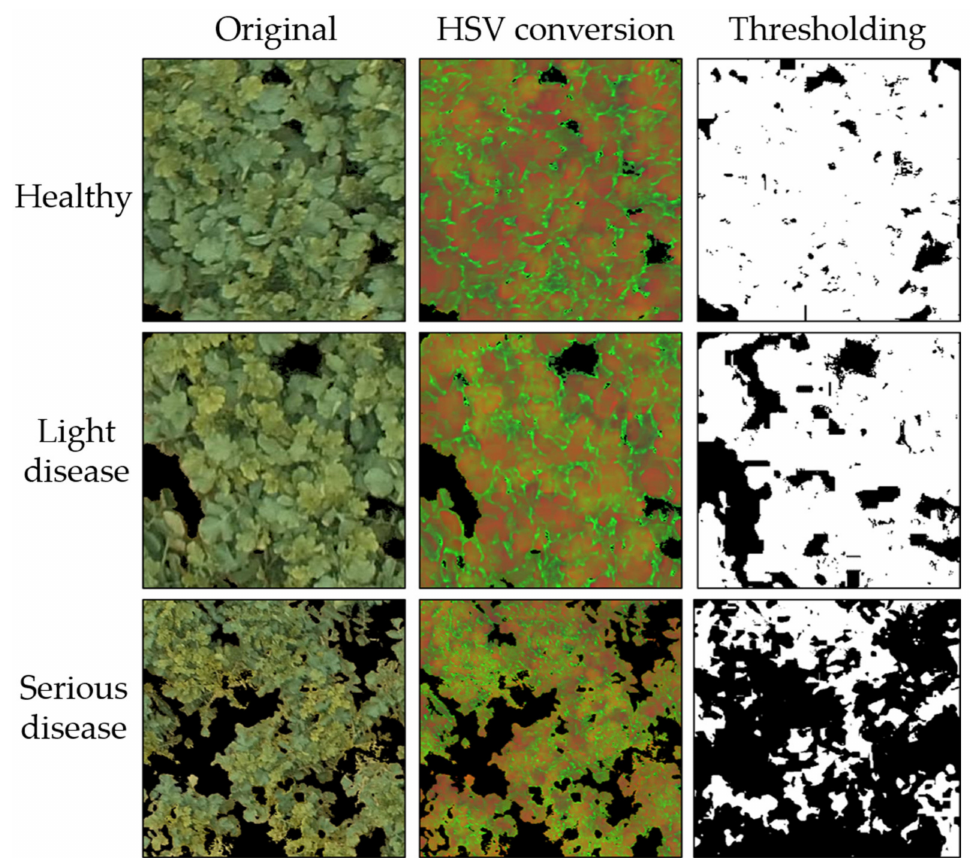
Figure 8. Disease severity classification process (scaled up to 100% from the original image). Each of the 64x64 radish images (first column) were converted to hue, saturation, lightness (HSV) colorspace (second column), and then the thresholding process (third column) was conducted to categorize the disease severity into healthy (first row), light (second row), or serious (third